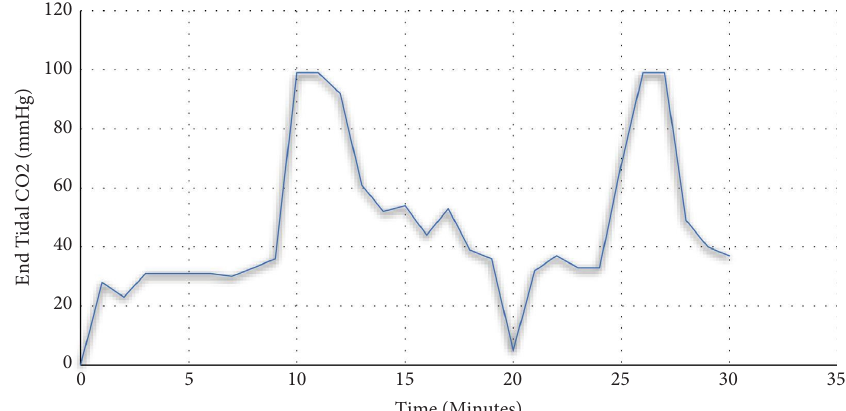
Figure 2: Capnography showing an abrupt end-tidal CO 2 rise to 99mmHg with full insufation of the esophagus with carbon dioxide (CO 2 ), suggesting the presence of